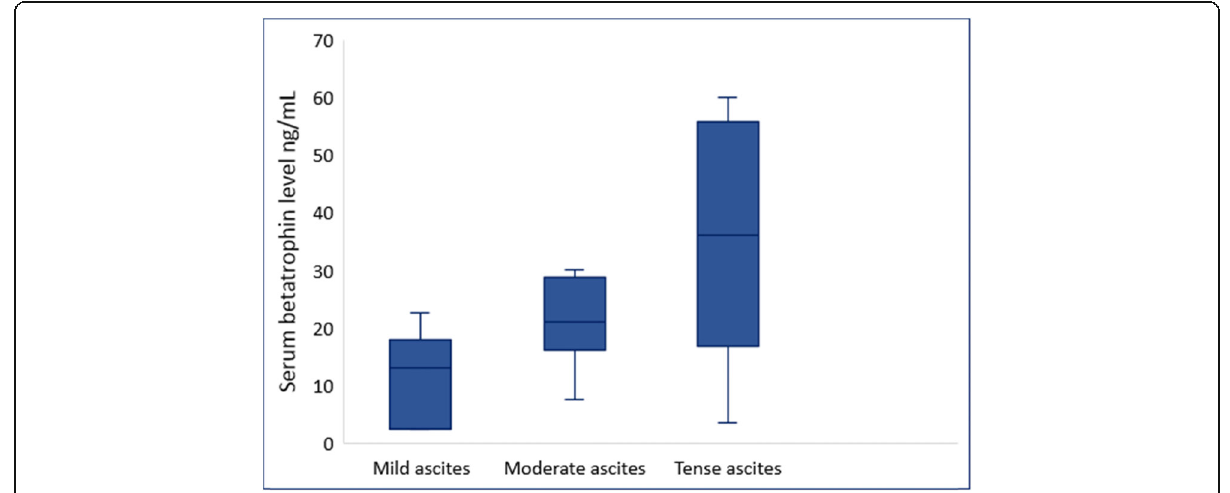
Fig. 3 Box plot showing serum betatrophin levels according to the degree of ascites